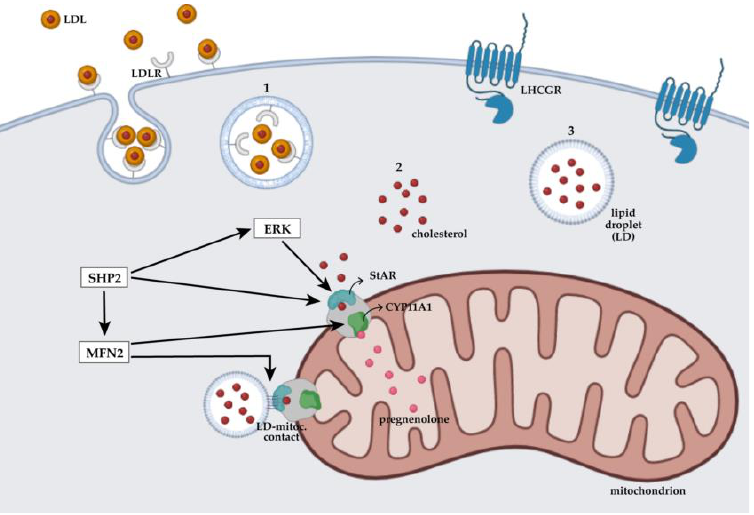
Figure 2. Steroidogenesis regulation in Leydig cells. The first critical step for the synthesis of steroids is the accumulation of cholesterol inside the cell. Here we represent a Leydig cell, expressing the specific receptor LHCGR. This cell type can obtain cholesterol in three ways: (1) through its transport via low-density-lipoprotein (LDL, in orange), captured thanks to its respective receptor LDLR and subsequently internalized in vesicles; (2) de novo synthesis in the cytosol; (3) accumulation in lipid droplets (LD). At this point, the cholesterol must be internalized in mitochondria for the first step of steroidogenesis to take place, and this translocation occurs thanks to StAR protein (in blue), which in turn is part of the so-called transduceosome (in gray). This complex is present on the mitochondrial membrane, highlighting the importance of their arrangement, which is finely regulated by MFN2, a known protagonist of mitochondrial fusion. In this context, MFN2 allows contacts between the lipid droplets and the mitochondrial membrane to further ensure the transport of cholesterol inside the organelle, where it reaches CYP11A1 (another component of the transduceosome, shown here in green) which transforms it into pregnenolone. This whole pathway is regulated by additional agents: (i) SHP2, a phosphorylase that acts on MFN2, ERK, and StAR, and (ii) ERK ensures the correct position of StAR on the mitochondrial membrane.